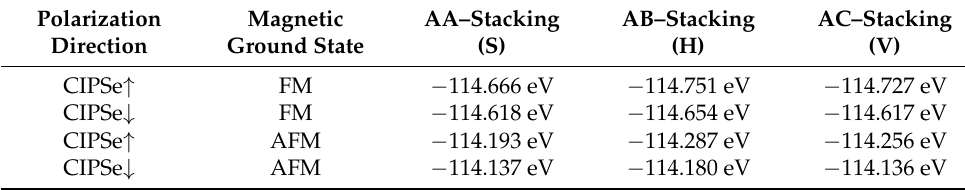
Table 1. Calculated total energies (eV) of 2H–VS 2 /CIPSe heterostructures for each stacking pattern with respect to different polarization directions and magnetic ground